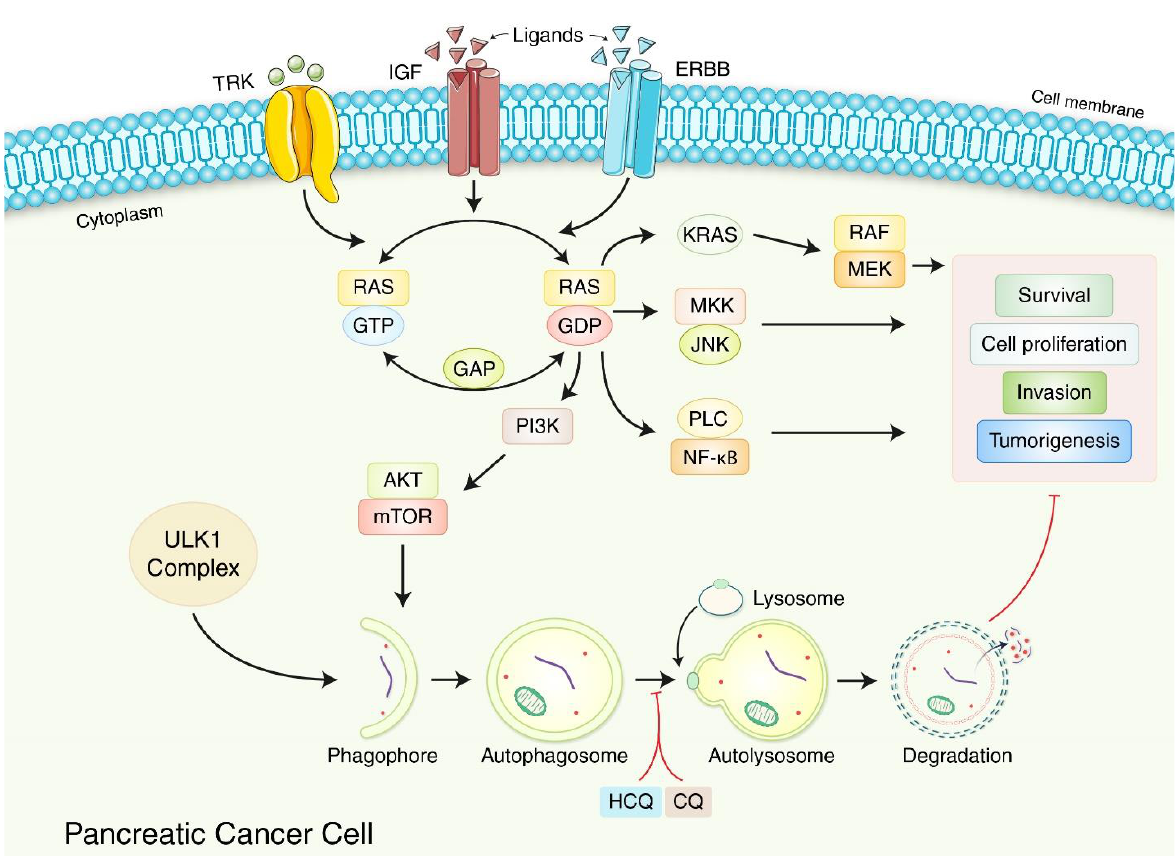
Figure 4. Autophagy-related PDAC therapies associated with the neuromere signaling